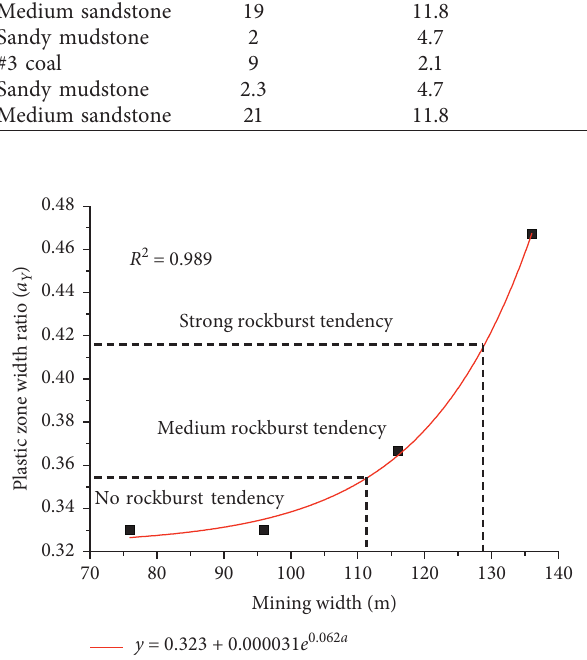
Figure 3: Fitting relationship of plastic zone width ratio and mining width.